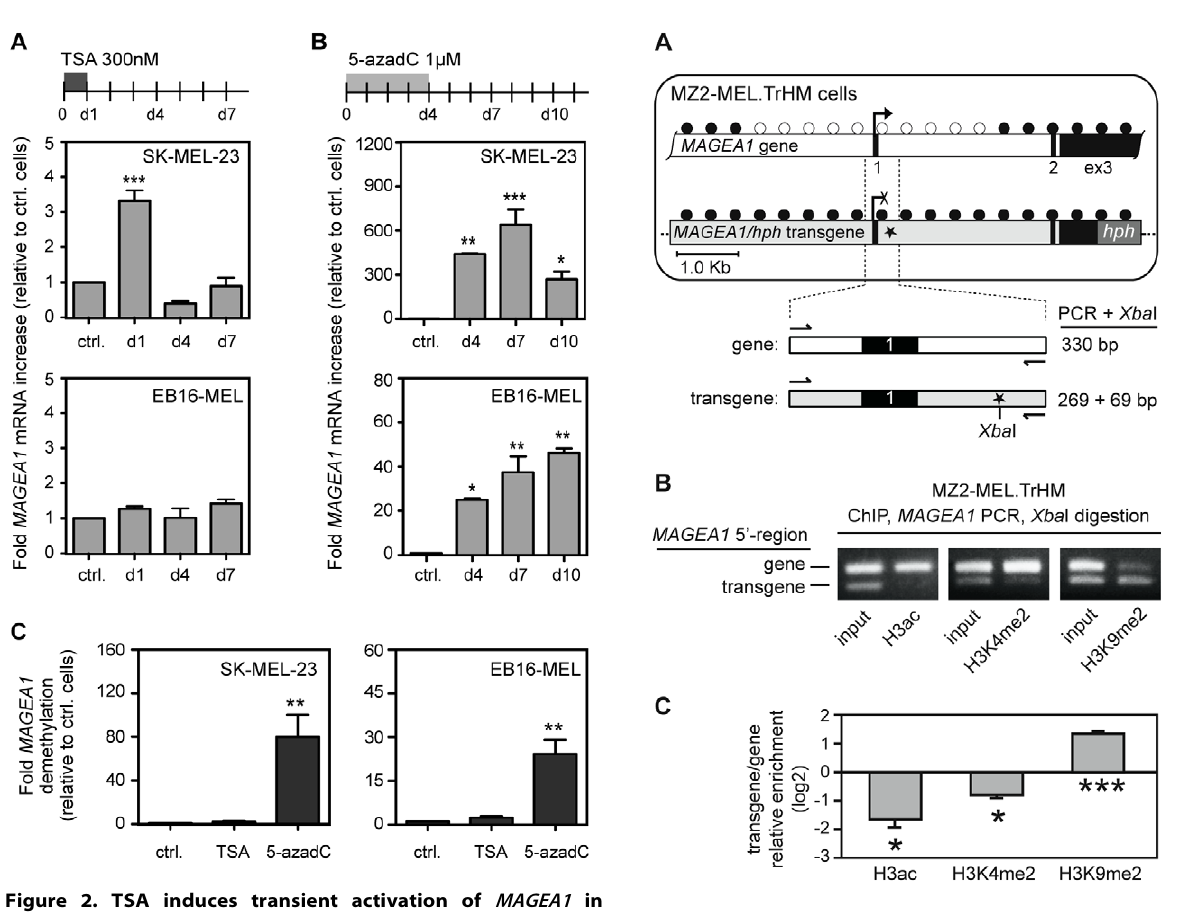
Figure 3. Histone modifications associated with an in vitro methylated MAGEA1 transgene. A , Schematic representation of the structure and DNA methylation status of the active unmethylated (empty circles) MAGEA1 gene and the inactive methylated (filled circles) MAGEA1/hph transgene in MZ2-MEL.TrHM cells. Black boxes correspond to the MAGEA1 exons, the dark gray box within the MAGEA1/hph transgene represents the hph transcription unit, and the asterisk (*) is the site where a 12-bp tag sequence (carrying a Xba I restriction site) was inserted. The lower panel is an enlargement of the amplicon that was amplified in ChIP experiments, and indicates the expected fragment sizes following Xba I digestion. B , ChIP experiments were applied to MZ2-MEL.TrHM. The resulting MAGEA1 amplicons were digested with Xba I and separated on agarose gels, thereby revealing relative enrichment of the indicated histone modifications within either the MAGEA1 gene (upper band) or the MAGEA1/hph transgene (lower band). C , Relative enrichment of histone marks on the transgene was deduced by quantifying band intensities in gel electrophoresis pictures (ImageJ software), and calculating the lower/upper ratio. Data, which were normalized by the lower/upper ratio in input samples, derive from at least two independent ChIP experiments, with two PCR/XbaI/ electrophoresis analyses in each case. * P , 0.05, *** P , 0.001.